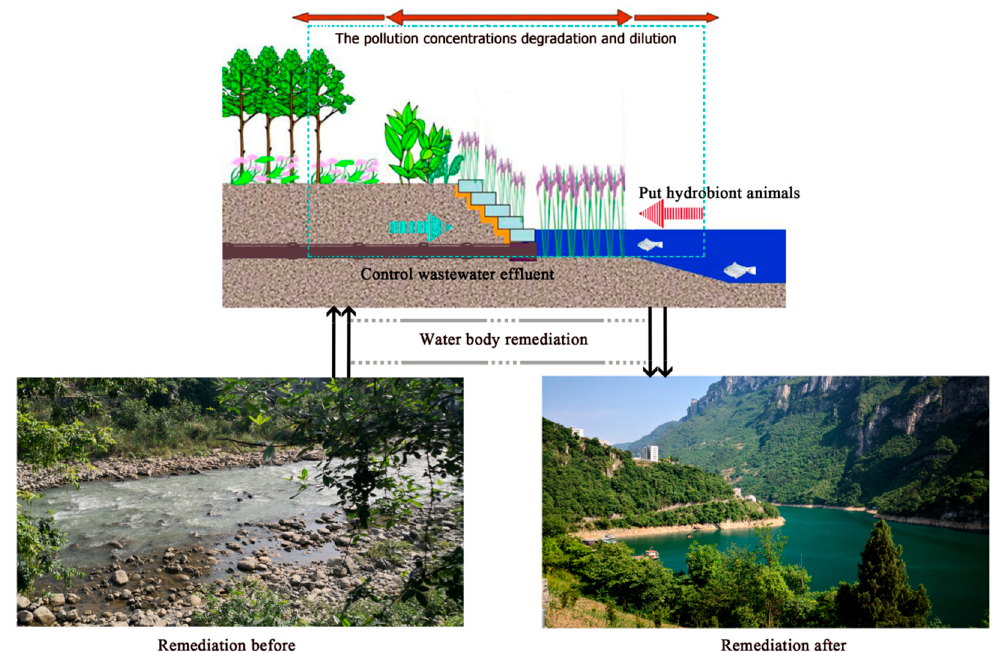
Figure 7. Visualization of the water body remediation process and results.